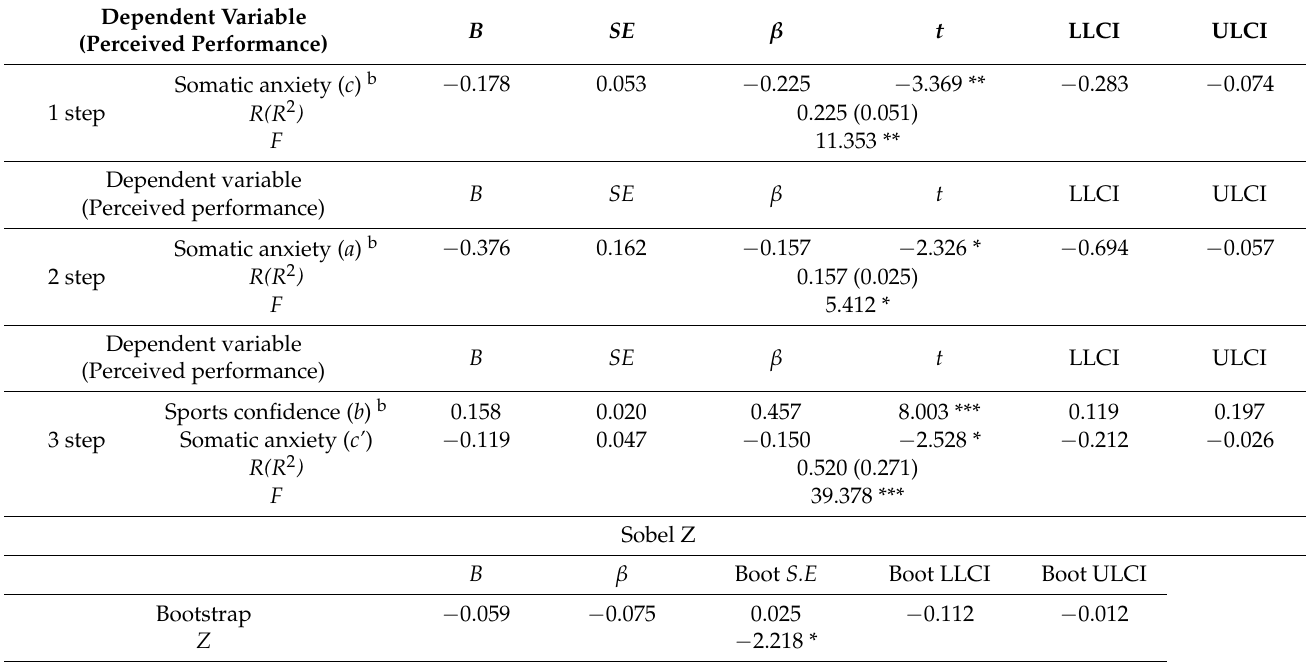
Table 7. Analysis of the mediating effect of sports confidence on the relationship between somatic anxiety and perceived performance ( n =